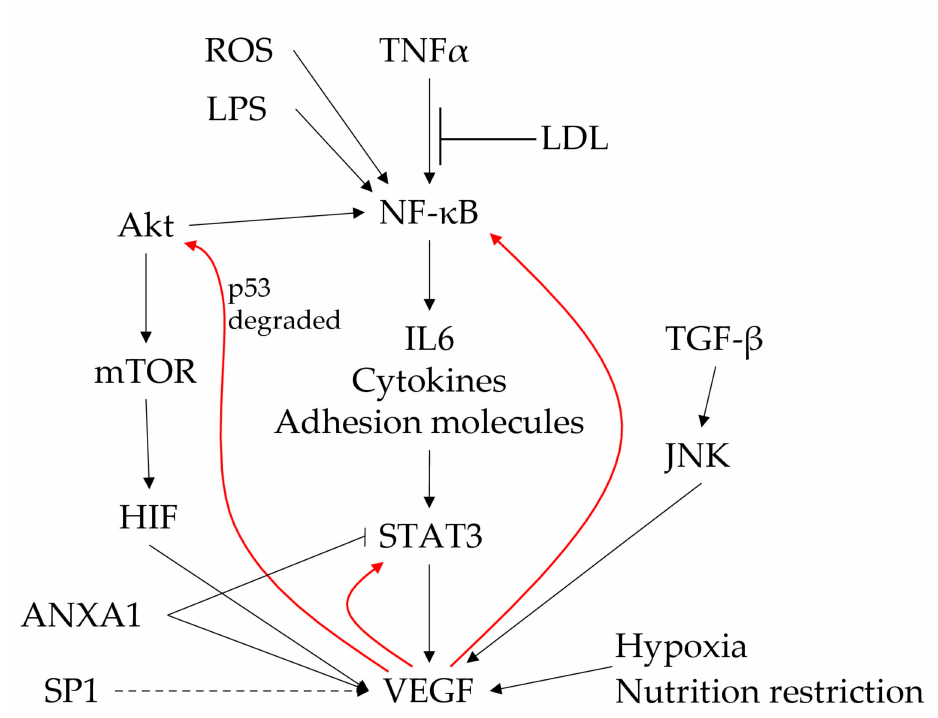
Figure 1. The central role of the VEGF and NF- κ B pathway in the control of inflammation-mediated angiogenesis. Red arrows represent VEGF-mediated autofeedback